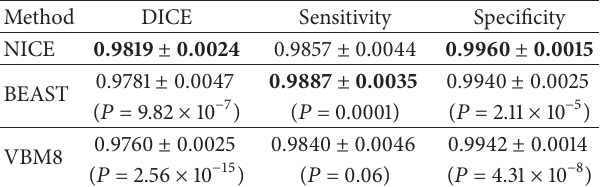
Table 3: Segmentation results of SVE dataset using different quality measures. NICE was compared to the other two methods ( 𝑃